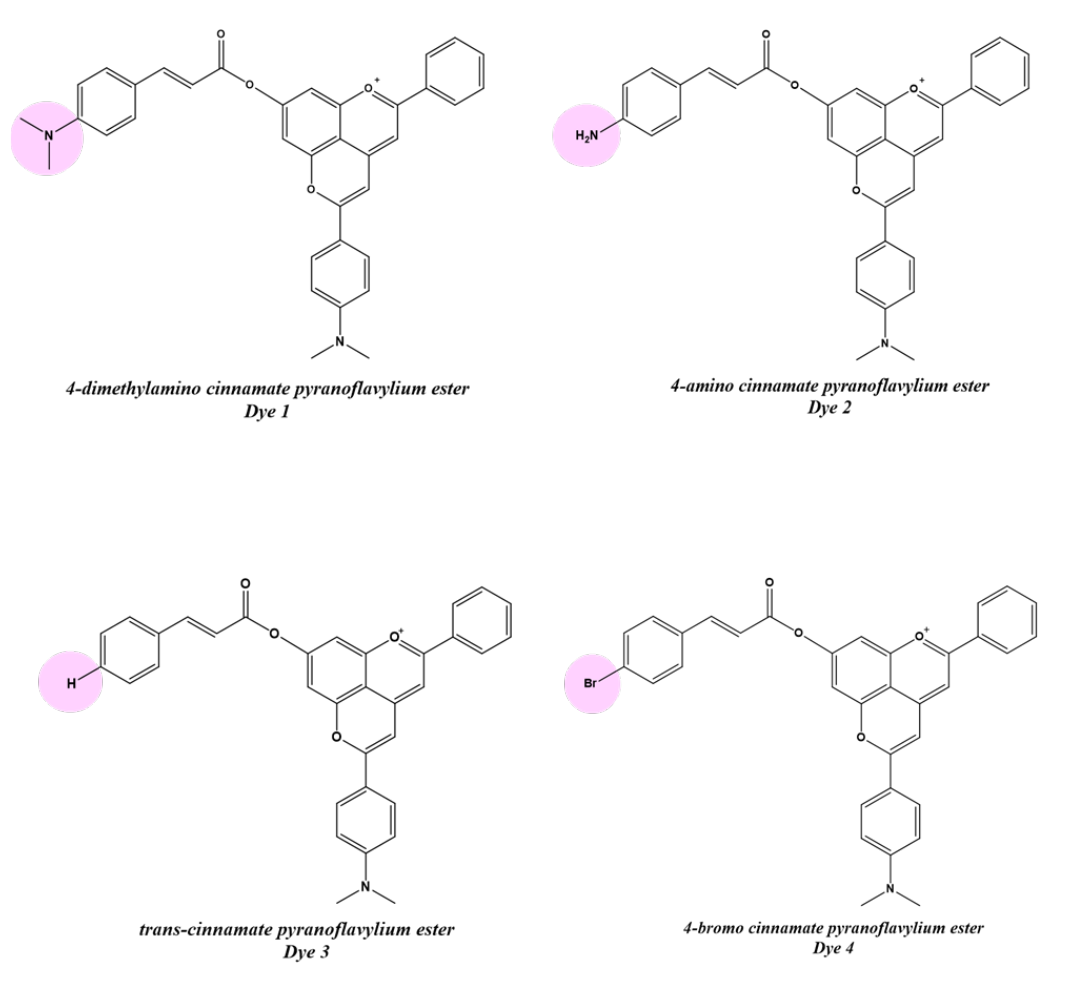
Figure 1. New dyes obtained by the esterification between cinnamic acids and a 7-hydroxyl pyra- noflavylium derivative using the EDC coupling agent.